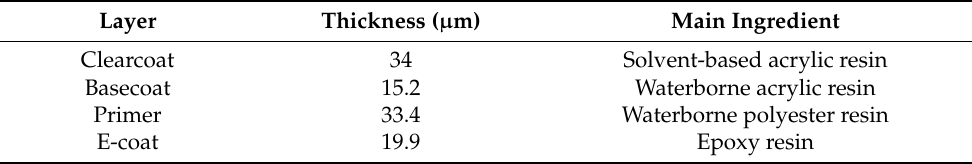
Table 1. The automotive coating system studied in the present